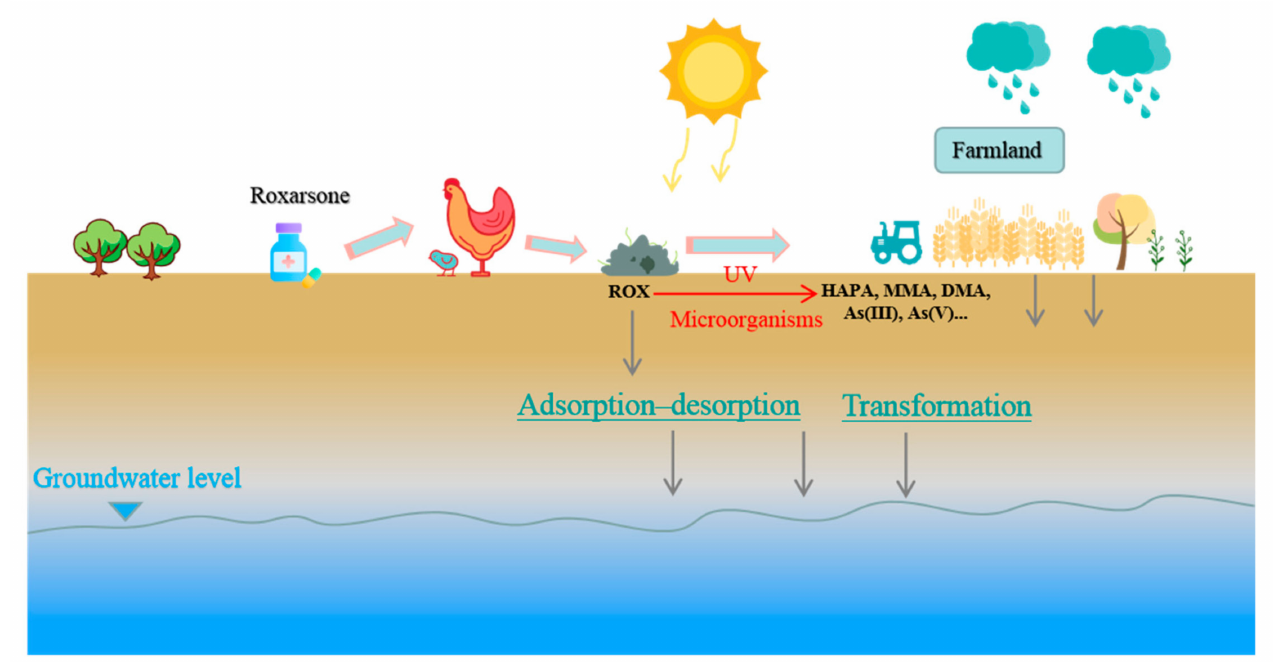
Figure 1. Environmental behavior of ROX used as feed